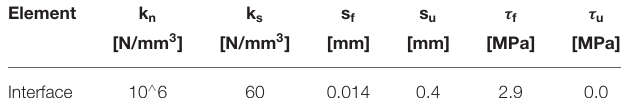
TABLE 3 | Bond-slip constitutive law parameters. Element